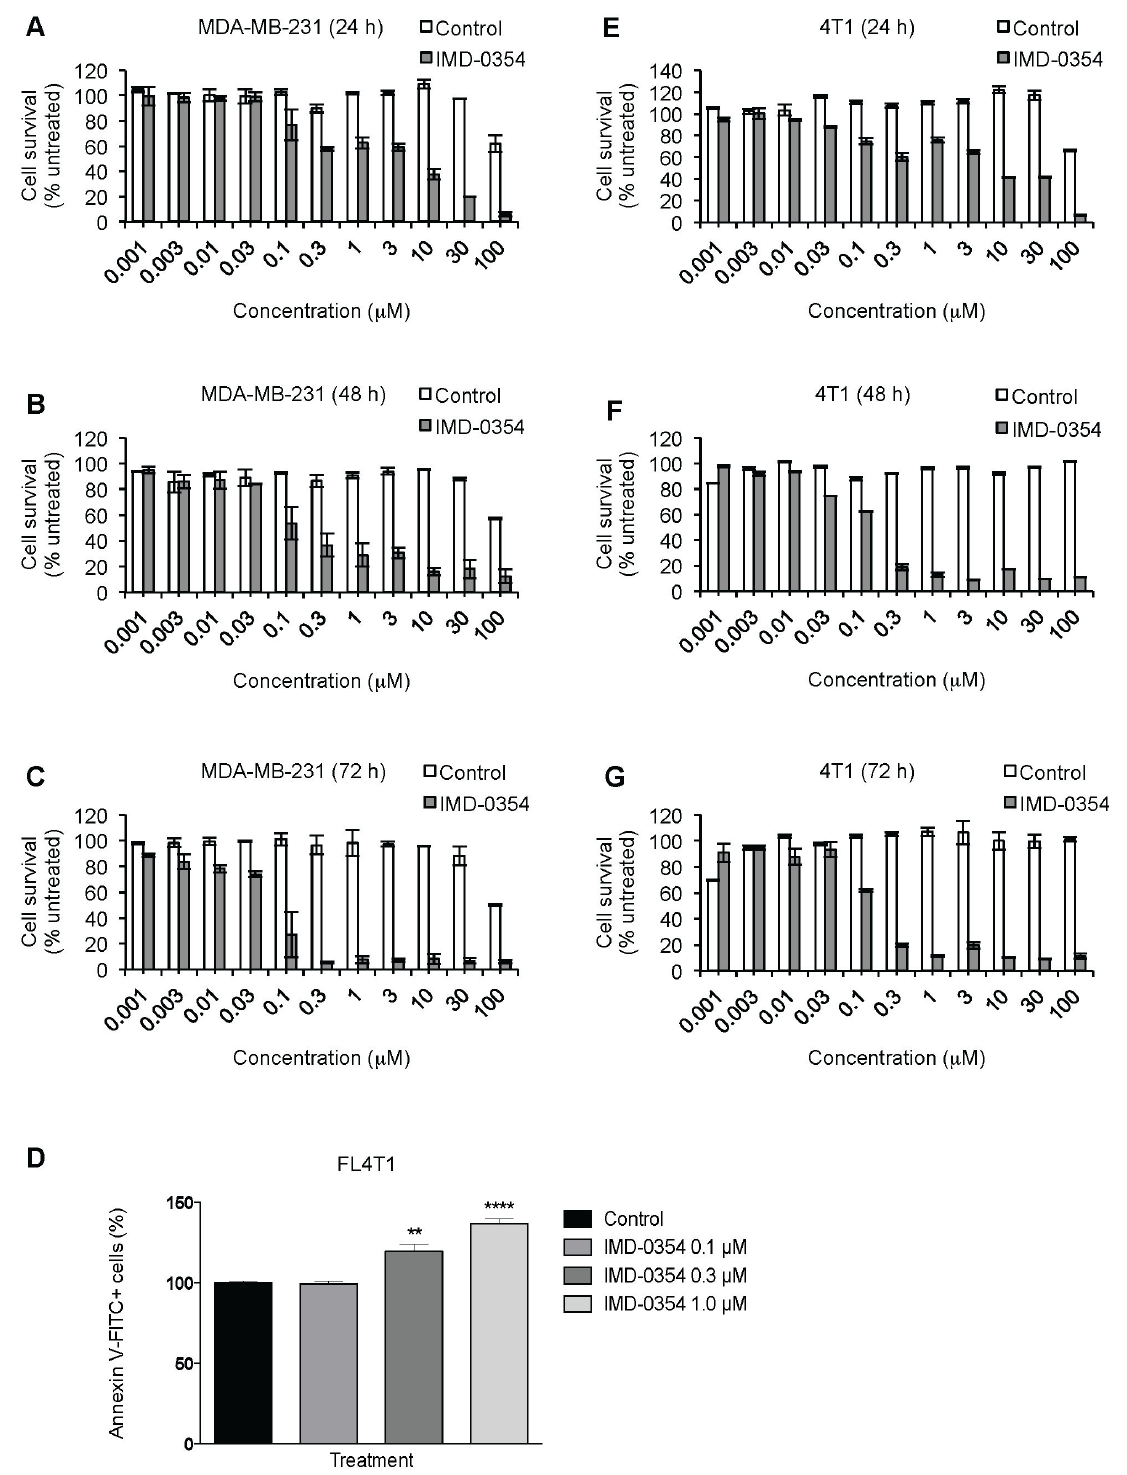
Figure 5. IMD-0354 effects on human and murine breast cancer cells. Viability of MDA-MB-231 cells was assessed by MTT assay after treatment with IMD-0354 for 24 h (A), 48 h (B) and 72 h (C). Apoptotic cells as Annexin V-FITC+ cells analyzed by FACS of FL4T1 cells treated with IMD-0354 (D). Viability of 4T1 cells was assessed by MTT assay after treatment with IMD-0354 for 24 h (E), 48 h (F) and 72 h (G). Data are shown as mean ± SEM. **P-value < 0.01; ****P-value < 0.001. doi: 10.1371/journal.pone.0073607.g005 PLOS ONE |